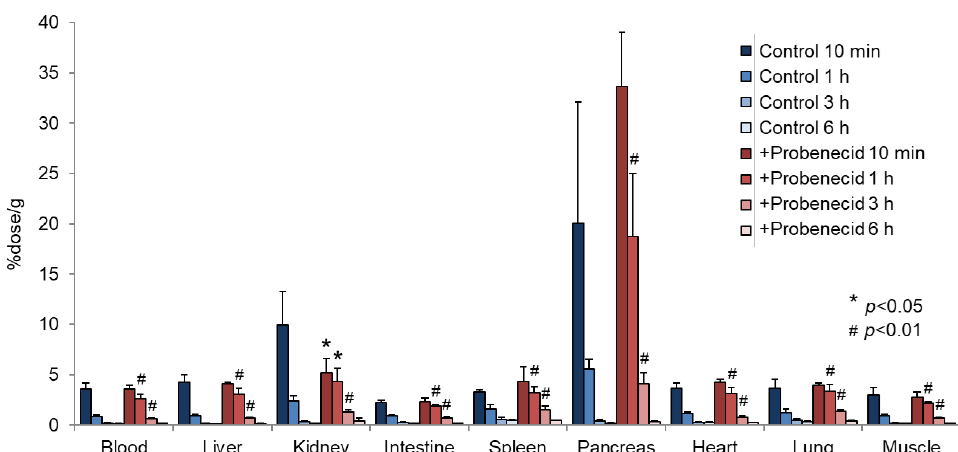
Figure 2. Biodistribution of 2- 211 At-AAMP in normal mice with or without intraperitoneal injection of probenecid (mean ± SD, n = 4). * p < 0.05 and # p < 0.01 compared with the control group (without probenecid preloading).